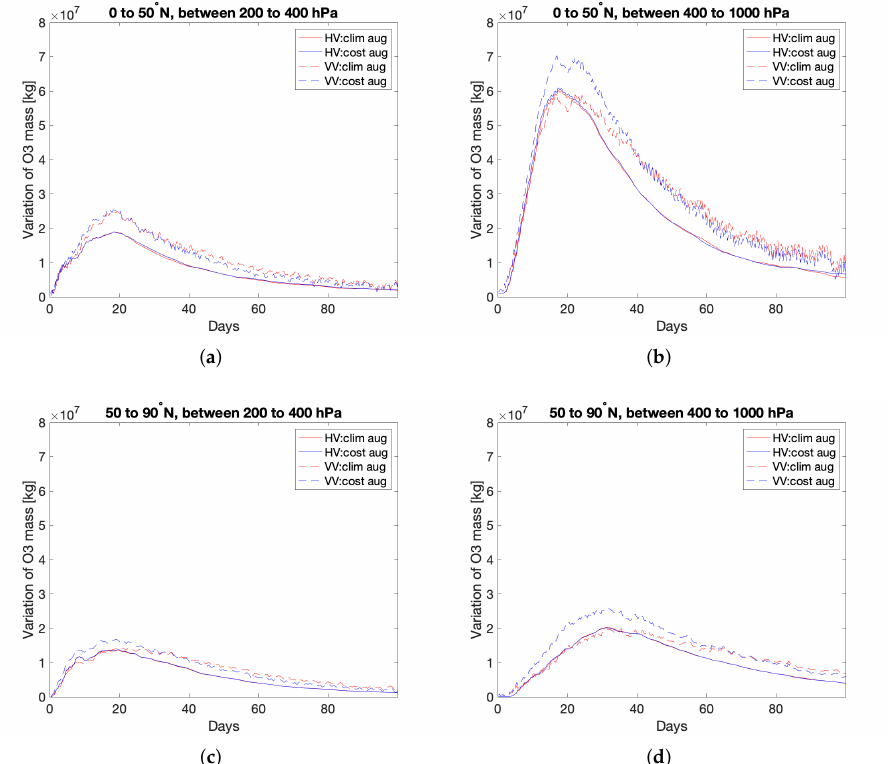
Figure 20. O 3 atf mass (kg) time series in specific regions from chemistry–climate simulations starting on 1 August 2016. The red and blue lines indicate the climate-optimised and cost-optimised cases, respectively, and the panel titles in ( a – d ) indicate the investigated